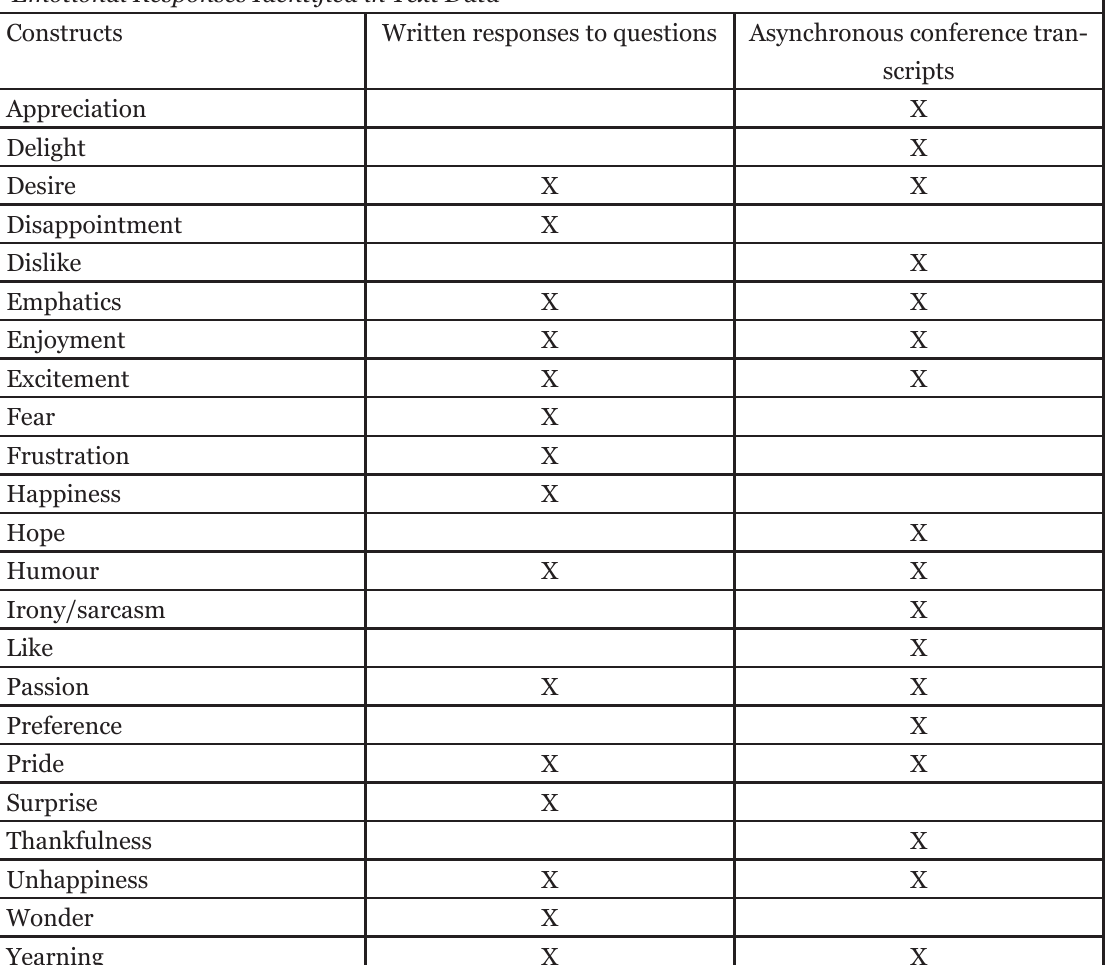
Table 1 Emotional Responses Identified in Text Data Constructs Written responses to